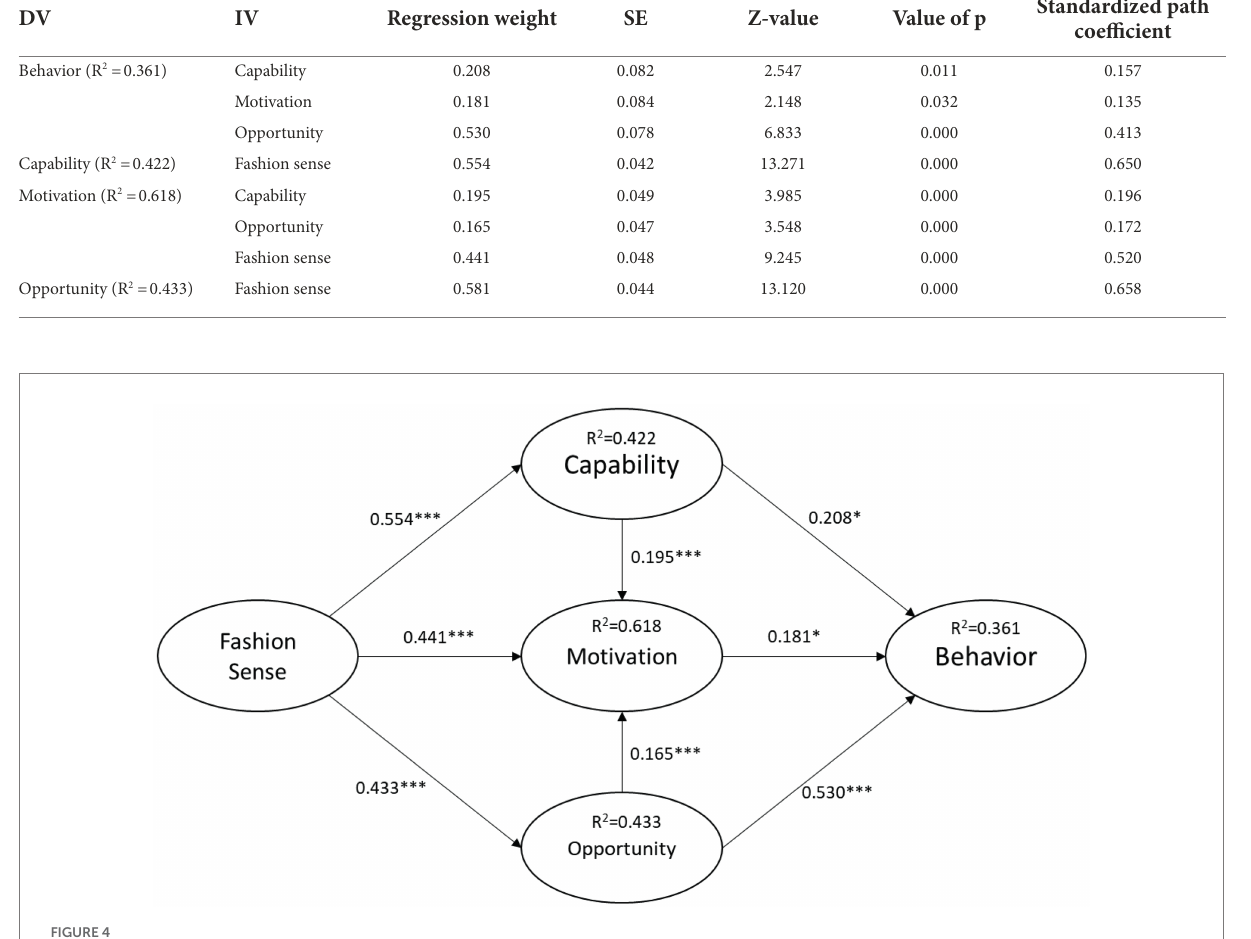
FIGURE 4 Structural model results.